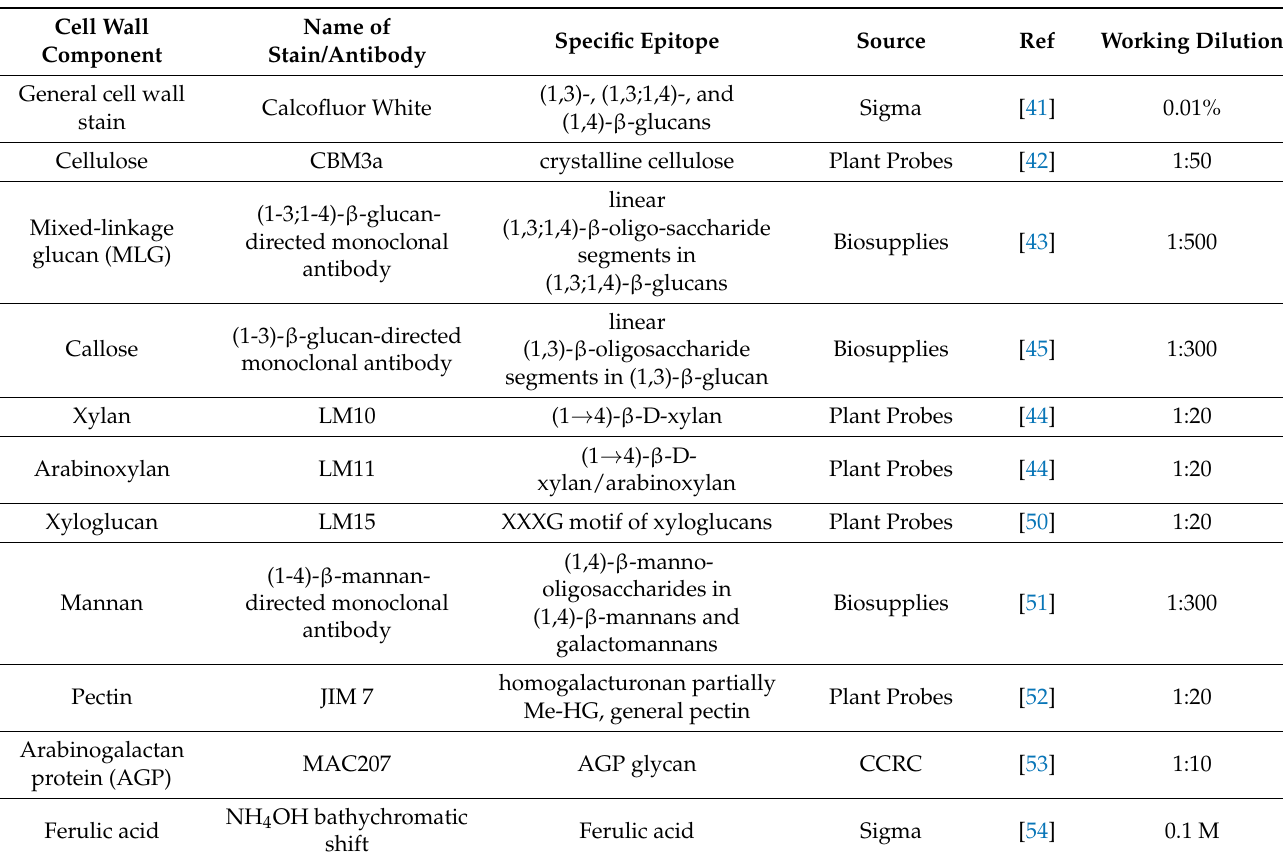
Table 1. The stain, carbohydrate binding module, and antibodies used to detect the various polysaccharides in the Lolium SCC cell